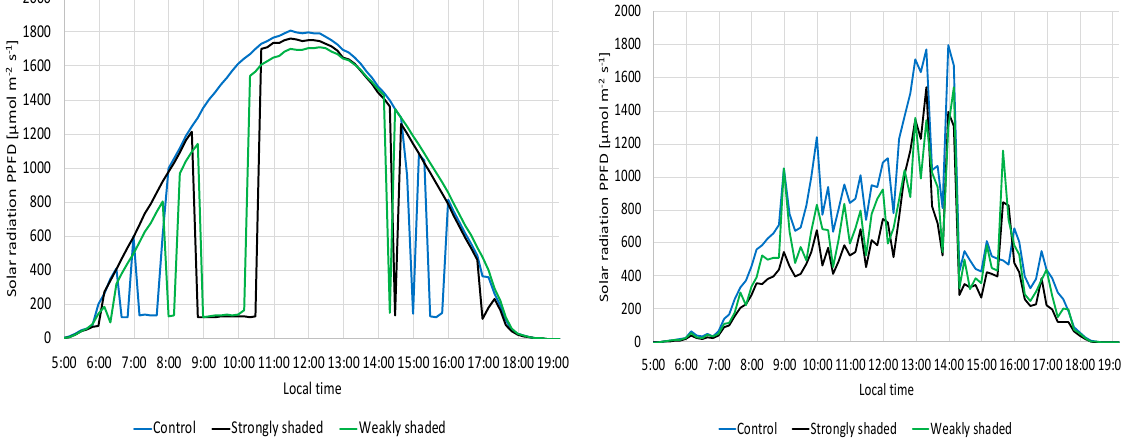
Figure 4. Changes in PPFD on a typical sunny day ( left ) and cloudy day (right ) at Farm A. As shown in Figure 5, we used a thermo-camera (TH9260, Nippon Avionics, Tokyo, Japan) on peak summer days on Farms B and C and found that the surface temperatures decreased by 2–4 °C in the shaded agrivoltaic plots. Previous studies have observed that, when the surface temperature increases owing to high exposure to sunlight in summer, the expected yield declines sharply because of the effects of high temperatures on leaves [52,54]. Such increases shorten the duration of phenological development of the crops [55,56]. Thus, installing panels above the crops can lessen crop exposure to high temperatures that may lead to stress [19,32,41,57].